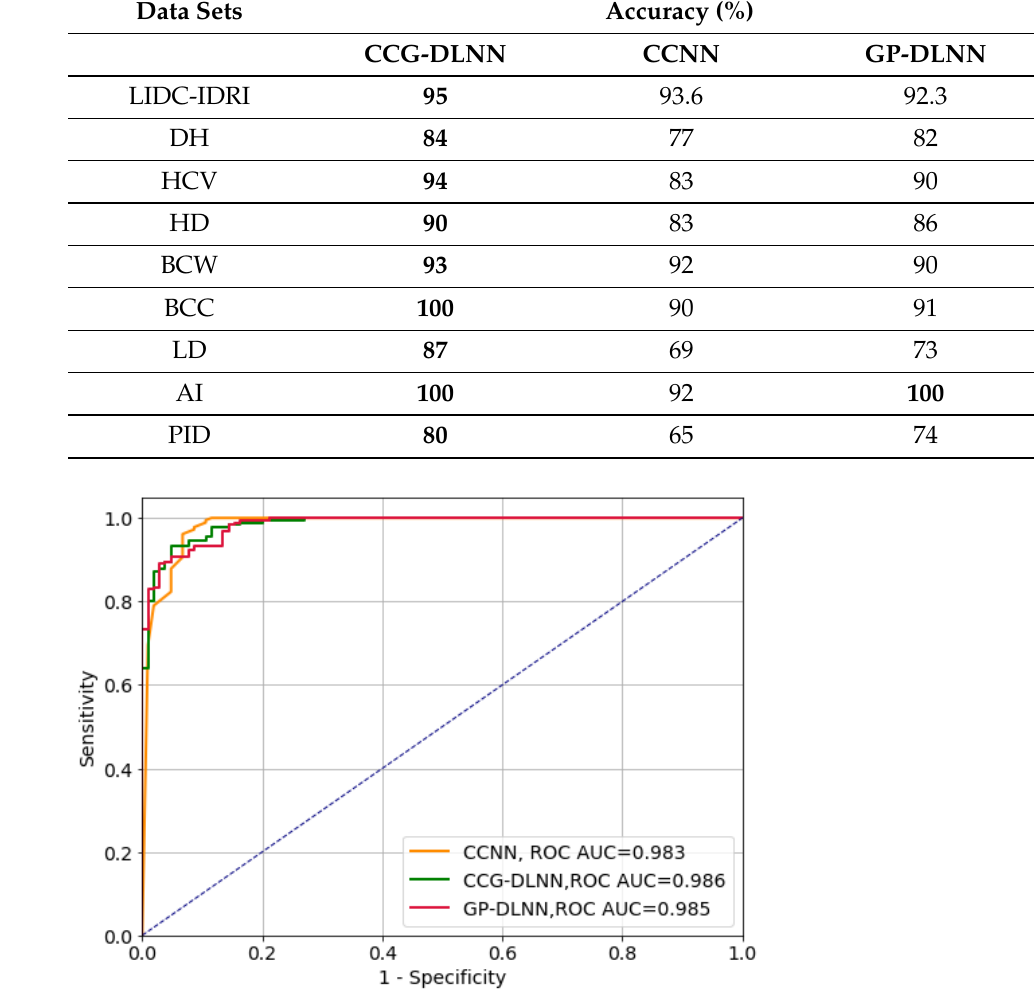
Figure 13. The ROC curves for CCG-DLNN, GP-DLNN and CCNN algorithms on the LIDC- IDR data